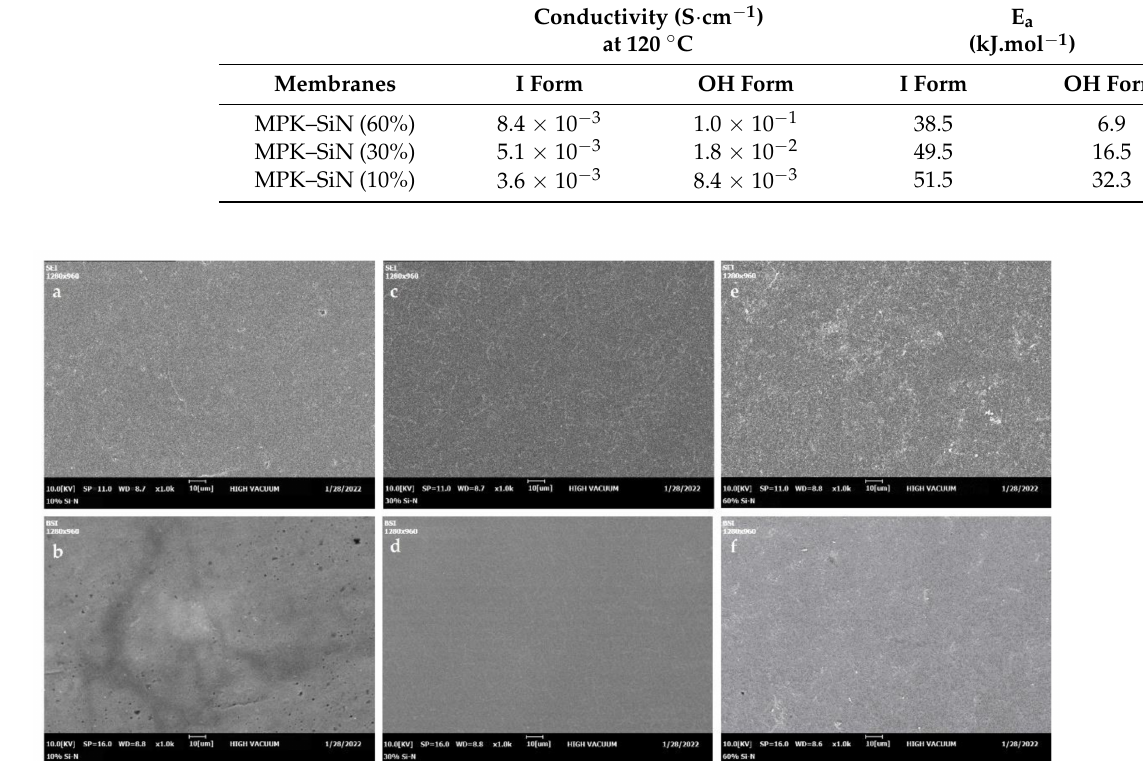
Figure 2. Surface morphology and backscattered (BSE) images of MPK–SiN membranes containing 10 wt% ( a , b ), 30 wt% ( c , d ), and 60 wt%, ( e , f ) of modified silica,